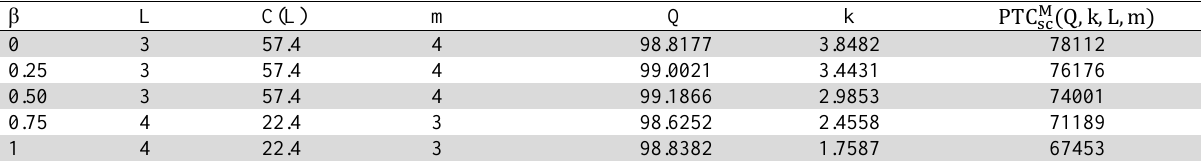
Summary of the optimal solution for numerical example